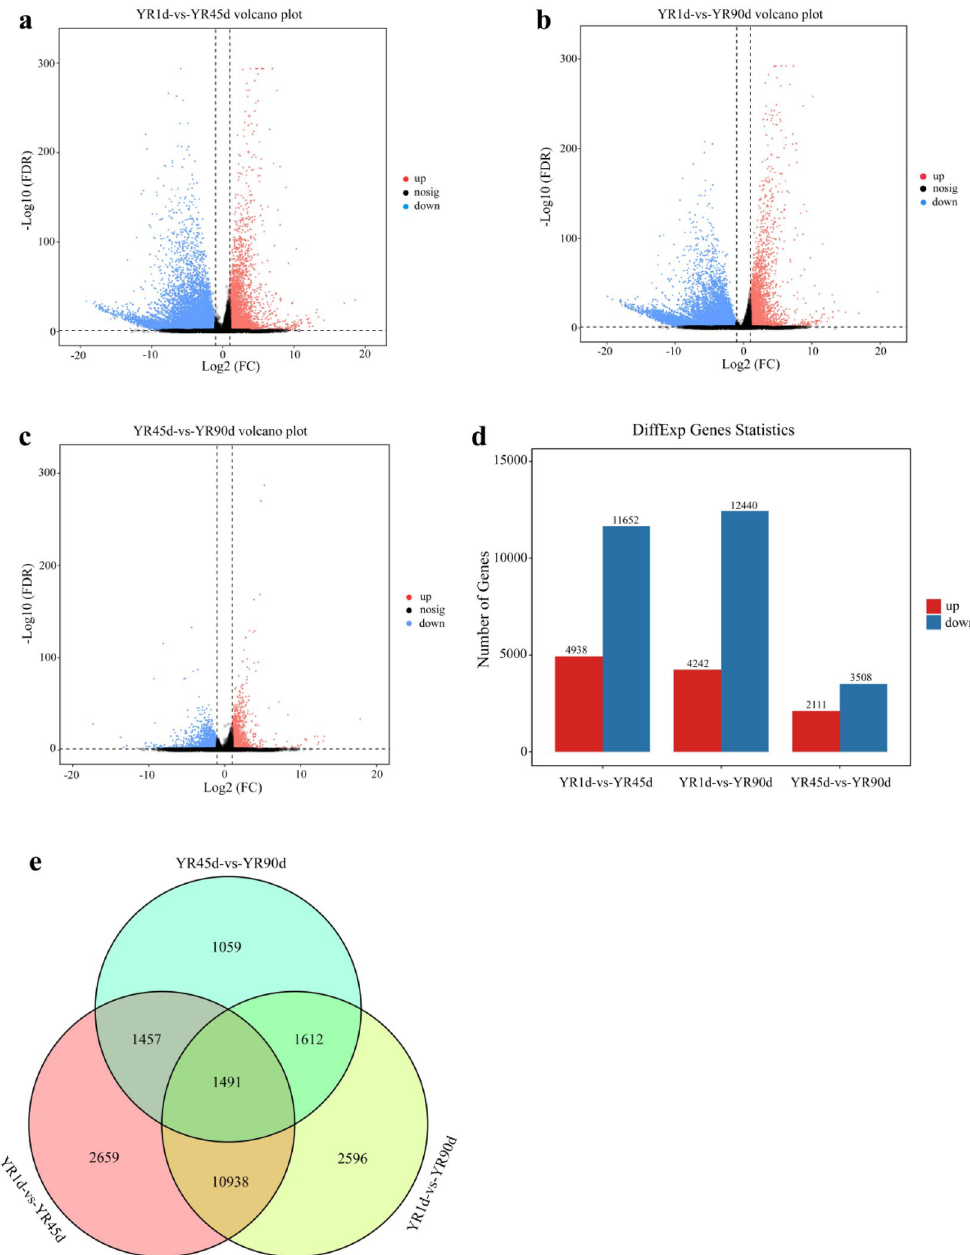
Figure 2. Distributions of differentially expressed genes (DEGs) and comparative results of RNA-seq among the three compared groups (YR1d vs. YR45d, YR1d vs. YR90d, YR45d vs. YR90d). ( a – c ) showed volcano scatter plot of DEGs among the three compared groups, respectively. ( d ) Numbers of upregulated and downregulated DEGs among the three compared groups. ( e ) Visualization of the DEGs in a venn diagram indicated that 1491 DEGs were shared among the three compared